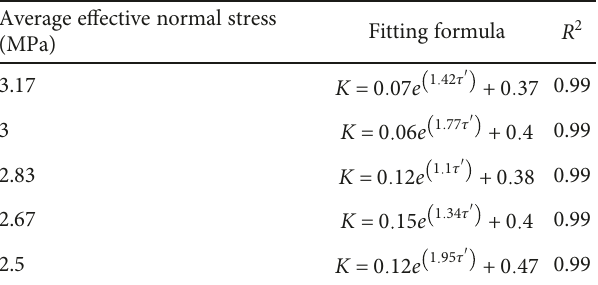
Table 4: Fitting